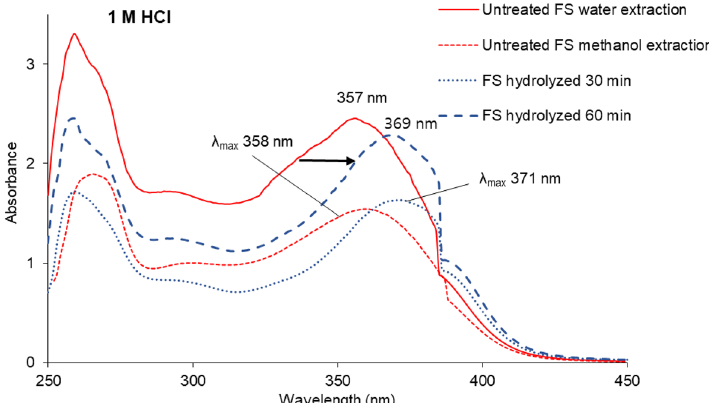
Table 5 Result of hydrolysis of Flos Sophorae extracted by water Sample Reaction time λ max (nm) Absorbance Relative yield of Untreated Flos Sophorae water extract 357 2.46 – Untreated Flos Sophorae methanol extract – Hydrolyzed Flos